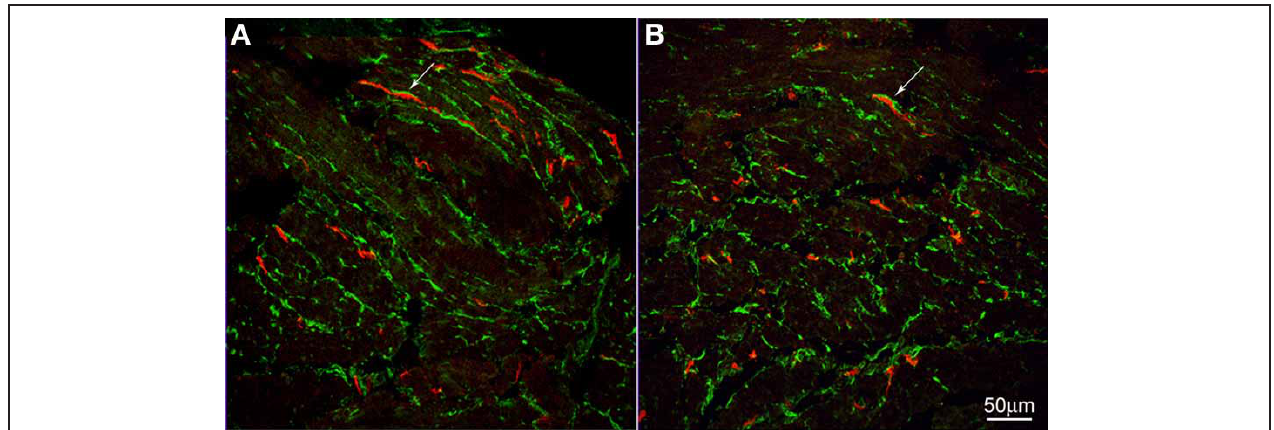
FIGURE 4 | c-Kit (red) and PDGFR α (green) immunoreactivities in control (A) and achalasia patient (B) (archived specimen). ICC and PDGFR α positive cells shared a similar distribution in esophagus. They were very close